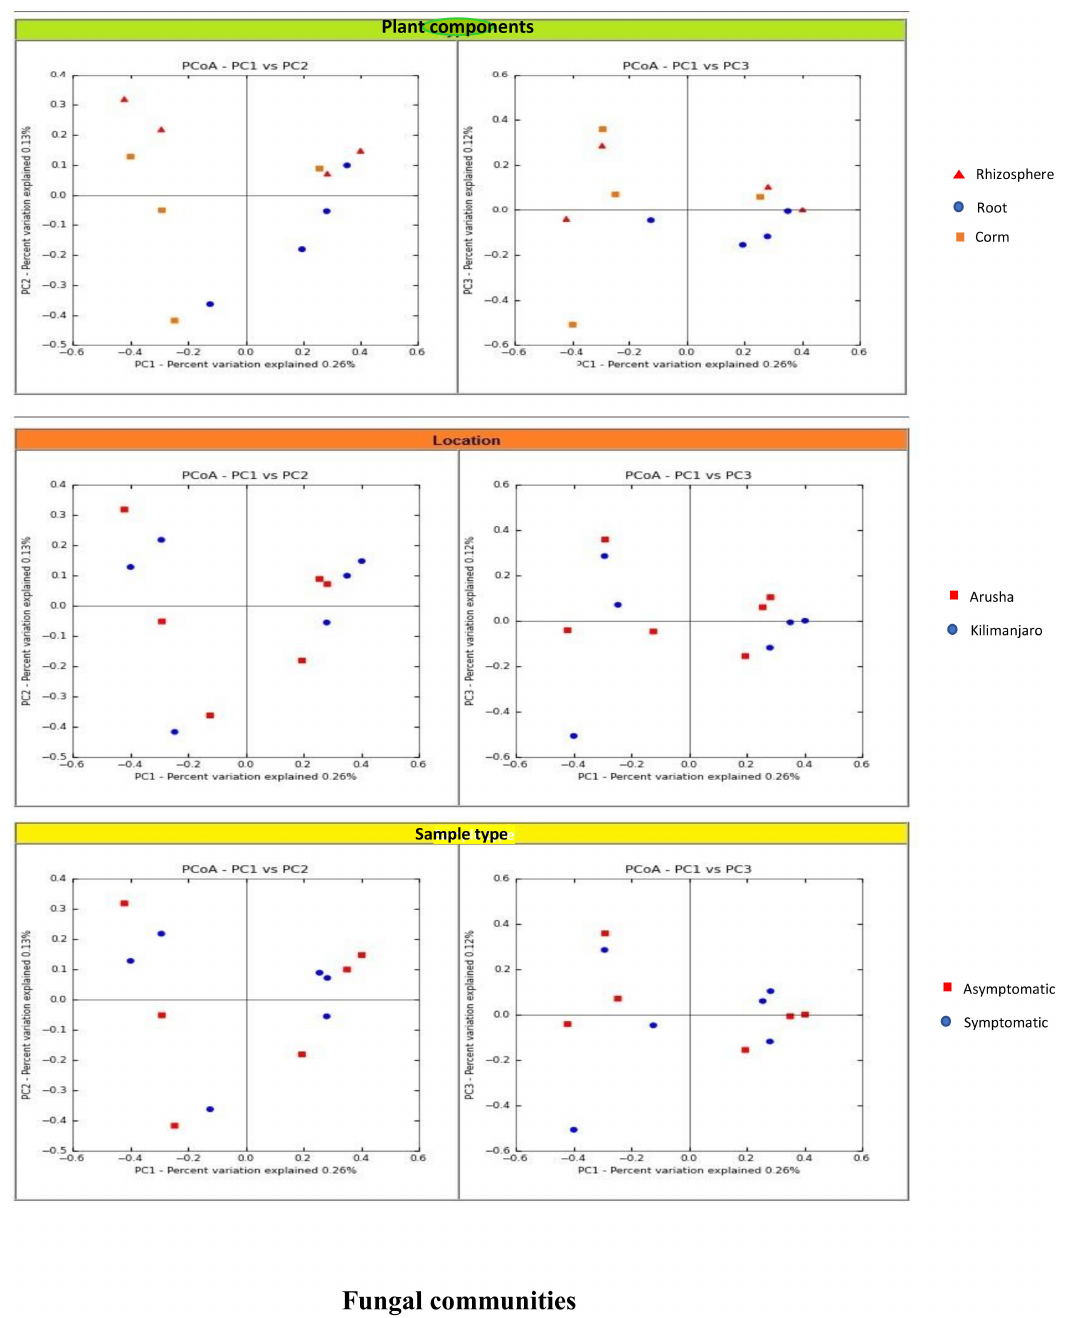
Figure 2. Factors driving the microbiota composition of bacterial and fungal communities in organs, locations, and sample types. The principal coordinate analyses (PCoA) of pairwise Euclidean distance matrixesoffilteredoperationaltaxonomyunit(OTU)tables. PCoAanalyseswereperformedconsidering all 12 samples of 16S and ITS based on three properties, i.e., sample organ (rhizosphere, roots, and corm of banana), location (Arusha and Kilimanjaro), and sample type (asymptomatic and symptomatic). For each group, the same graph was di ff erentially colored to emphasize the influence of sample type and location of sample in the community